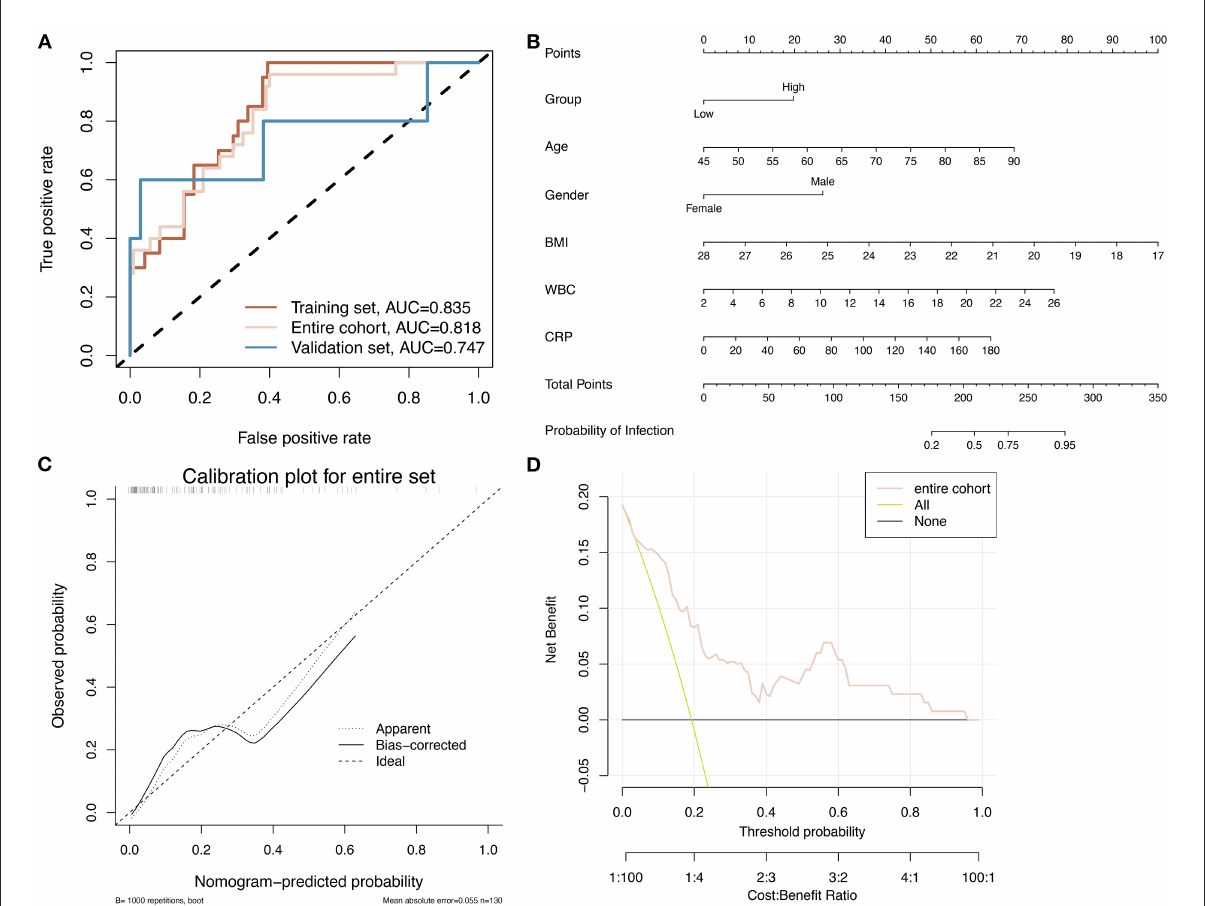
FIGURE3 A nomogram based on six factors is constructed and its accuracy is assessed. (A) The ROC curves for the logistic regression model constructed based on the six identified clinical factors for infection in training, validation, and overall pairwise column sets demonstrate better classification performance in all three datasets. (B) The nomogram was constructed using a logistic regression model. (C) Calibration plot showing the predicted values of the model are roughly consistent with the true labels, indicating that the model is reasonably accurate. (D) Clinical decision curve showing the prediction results in an overall pairwise